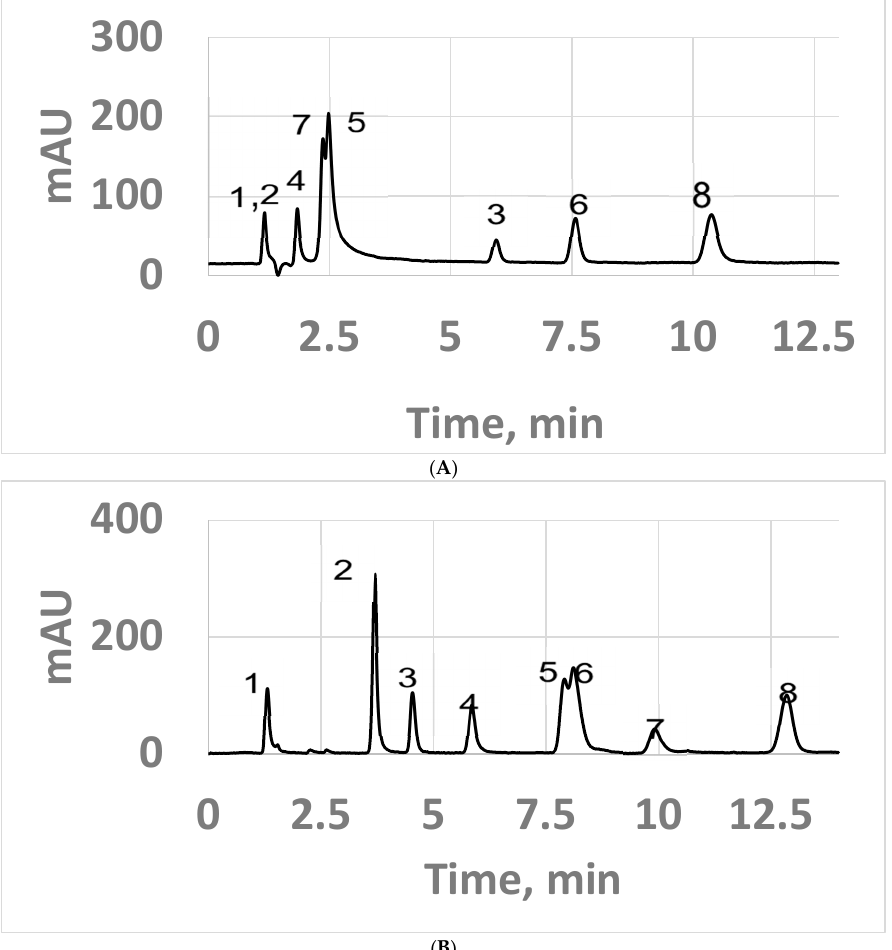
Figure 7. Separation of a mixture of mono- and di-hydroxybenzoic acids. ( A ) The 89% acetonitrile–11% 100 mM buffer/ethanol; ( B ) 89% dimethyl carbonate–11% 10 mM buffer/ethanol. Peak ID: 1—toluene; 2—2,6-DHBA; 3—p-HBA; 4—o-HBA; 5—2,4-DHBA; 6—m-HBA; 7—2,5-DHBA; and 8—3,5-DHBA.